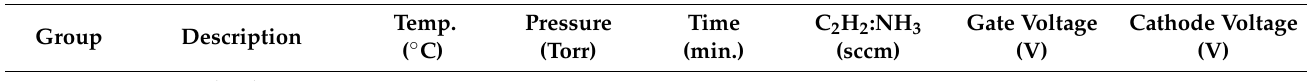
Table 1. Growth condition of VACNT emitters.